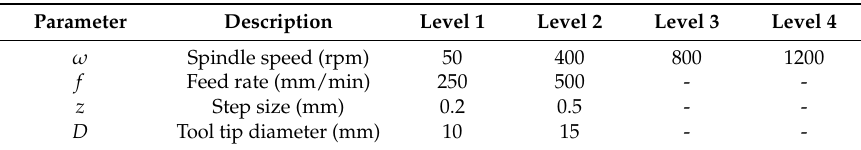
Table 2. Process parameters and their